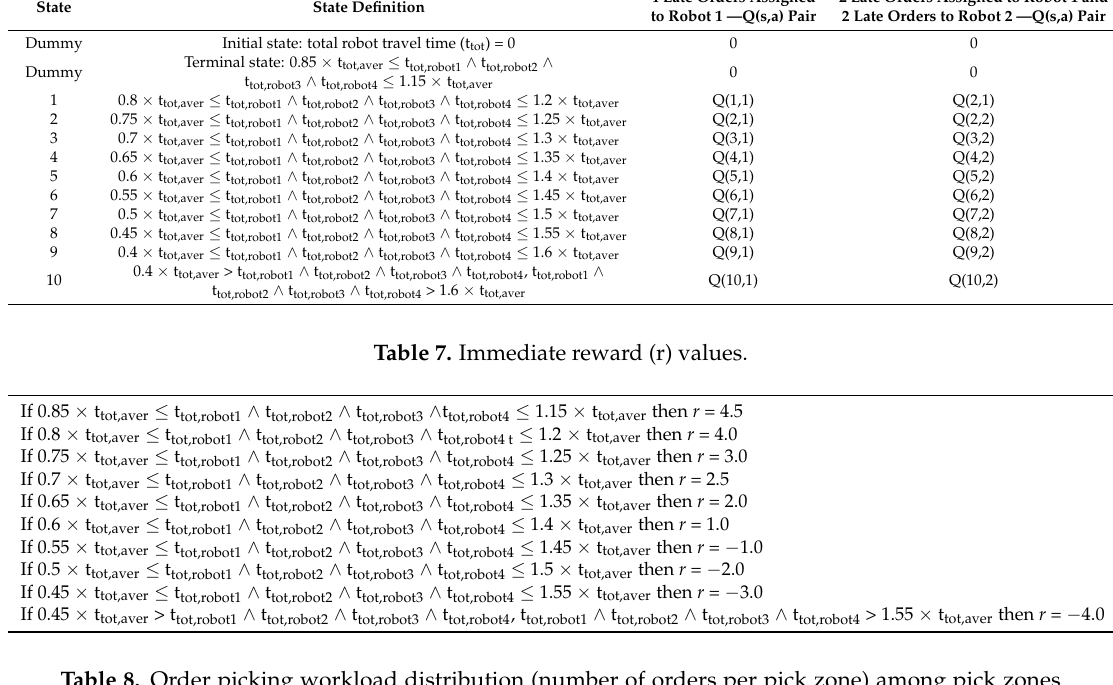
Table 8. Order picking workload distribution (number of orders per pick zone) among pick zones under emergence, for the different policy actions, for one batch of 28 orders with mean order size three line items per order and four emergency orders. Workload distribution under normal conditions (i.e., in the absence of emergency orders) has been